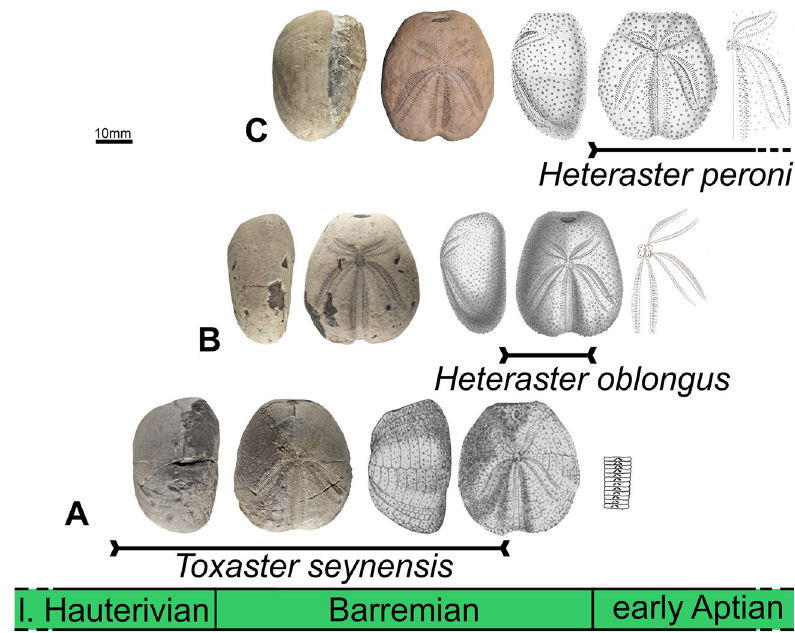
Fig. 6 Echinoids of biostratigraphical value present in the uppermost Hauterivian to lower Aptian series (Tierwis Formation, Schratenkalk Formation and Garschella Formation pro parte) of the Alpstein massif. A Toxaster seynensis (Lambert, 1920), drawing by Lambert (1920) and organization of the pores of the odd ambulacrum according to Clavel in Charollais et al. (2009). B Heteraster oblongus (Brongniart, 1821), drawing by d’Orbigny (1853–1855). C Heteraster peroni (Ficheur, 1900), drawing by Ficheur